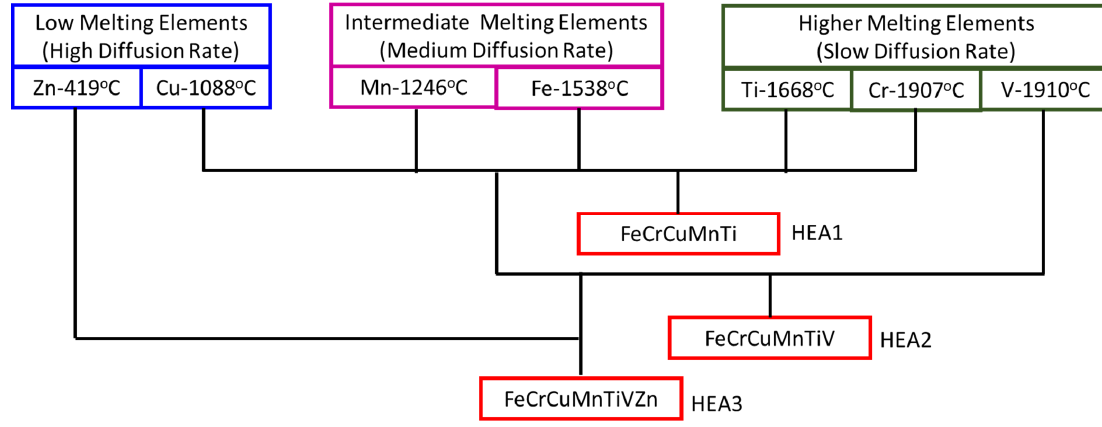
Figure 14. Schematic representing the diffusion rate of each HEAs defining their densification performances.